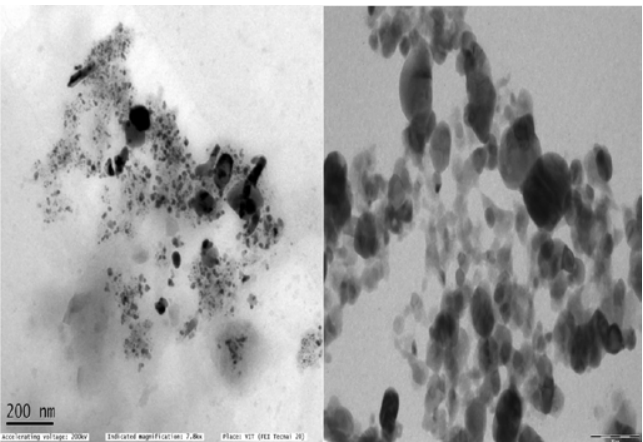
Fig. 3. Transmission electron microscopy analysis for Caryota urens silver nanoparticle